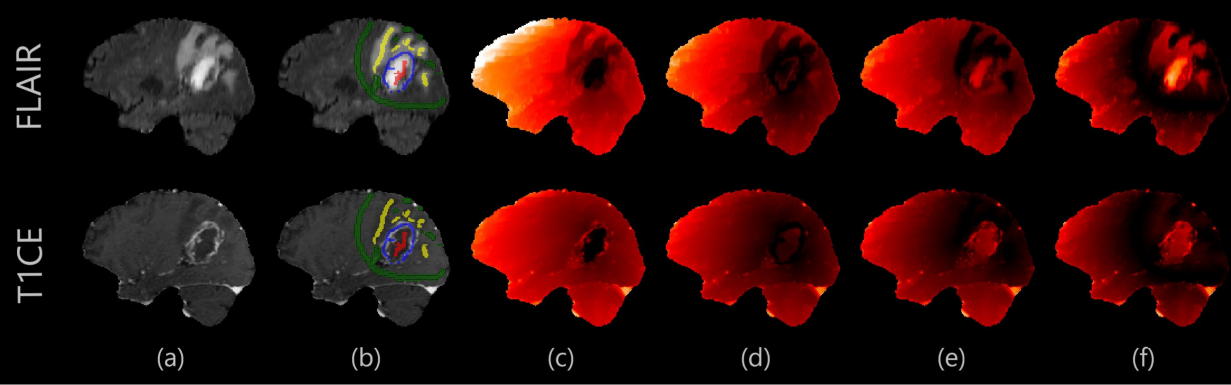
Figure 2. Example of AGD maps. Darker values indicate lower adaptive geodesic distance from the user drawings. In glioblastomas, non-enhancing tumor (NE) and enhancing tumor (ET) boundaries are clearer in T1CE, while the boundary between edema (ED) and background is clearer in FLAIR. From left to right: ( a ) Anatomical image; ( b ) User annotations; ( c ) Adaptive geodesic distance (AGD) map for NE annotation; ( d ) AGD map for ET; ( e ) AGD map for peritumoral edematous/infiltrated tissue (ED); ( f ) AGD map for